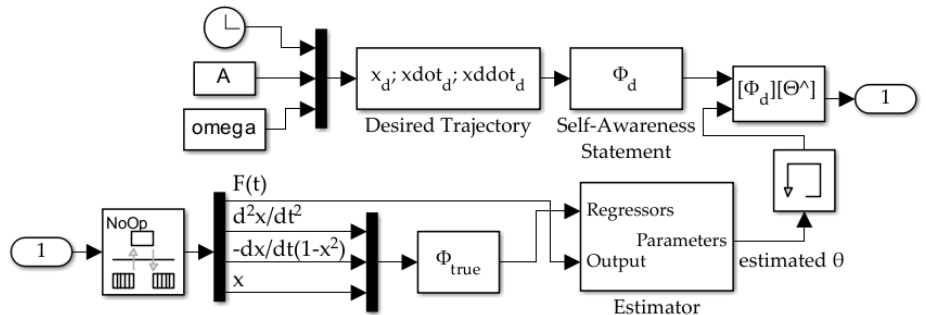
Figure 6. The forcing function block, 𝐹(𝑡) , adding DAI feedback as derived in [10,16]. In the de- picted simulation, the Estimator block utilizes one of three methods to calculate 𝜃̂ : Kalman filter, recursive least squares with exponential forgetting, and normalized gradient least mean squares.